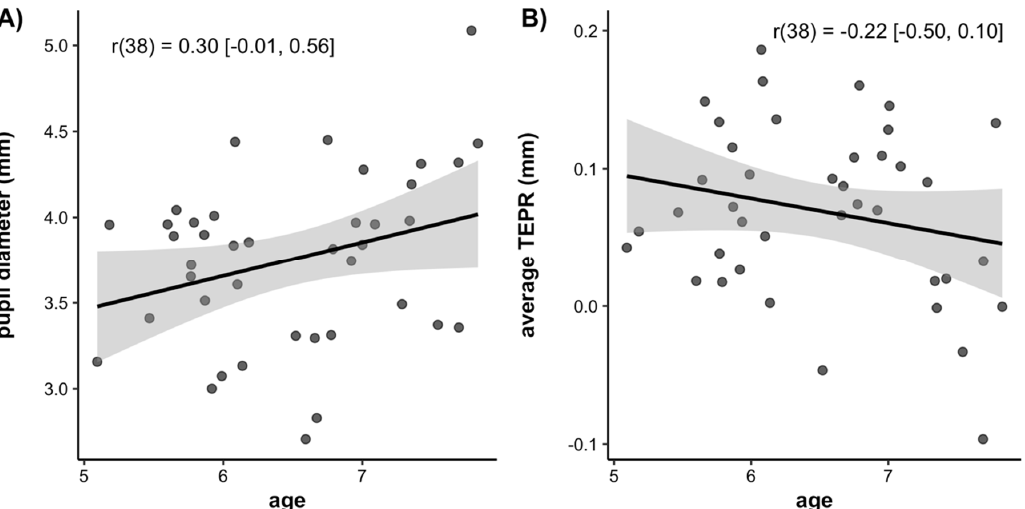
Figure 7. Scatterplots of the correlations between ( A ) Age and average baseline pupil diameter, ( B ) Age and average task-evoked pupillary response. Lines of best fit are drawn through the data points with associated standard errors. Correlation values are listed with the 95% confidence interval around the estimate.